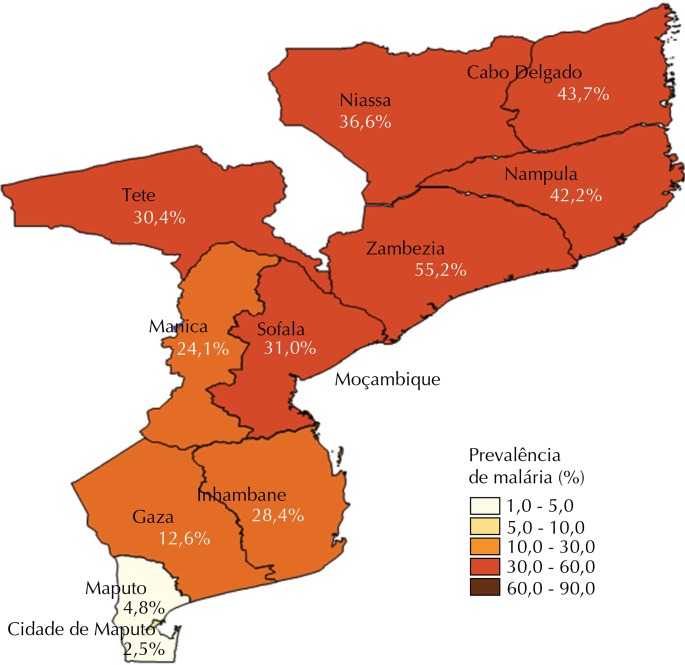
Prevalência da malária por províncias. Moçambique, 2011.